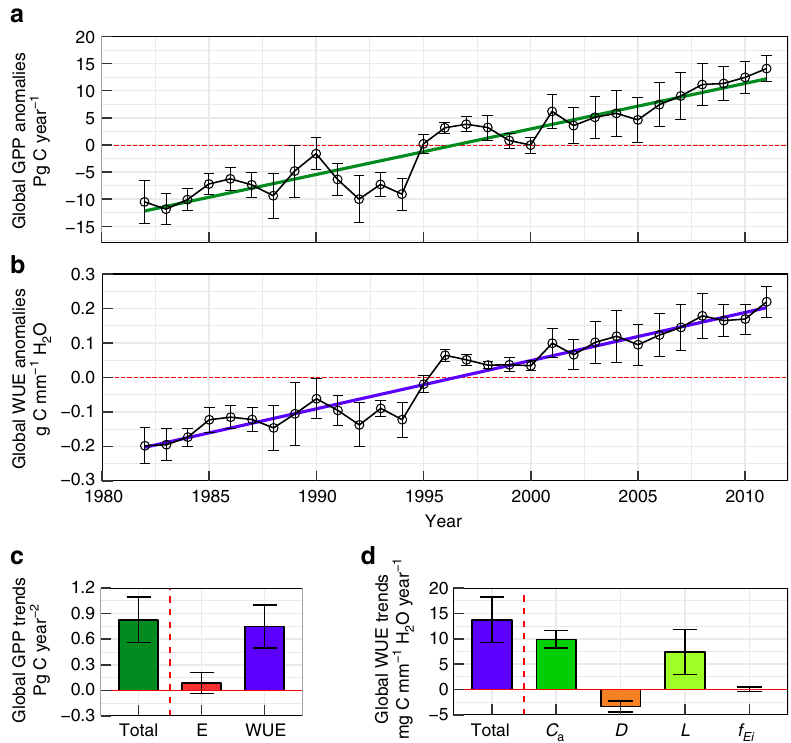
Fig. 2 Estimated trends in global gross primary production (GPP) and water use ef fi ciency (WUE) and their drivers over 1982 – 2011. a , b Annual mean anomalies and its standard deviation (shown as error bars) of global GPP in Pg C per year ( n = 84) and global WUE in g C mm − 1 H 2 O ( n = 12) during 1982 – 2011, respectively. The green line in a and blue line in b represent the linear trend over the past three decades. c Contribution of E and WUE to total global trends in GPP (Total). d Contributions of four factors to the total increase in global WUE (Total). C a , D , L and f E atmospheric CO 2 concentration, vapour pressure de fi cit, leaf area index and fraction of canopy interception to total ecosystem water use, respectively. The error bars in all the subplots represent one standard